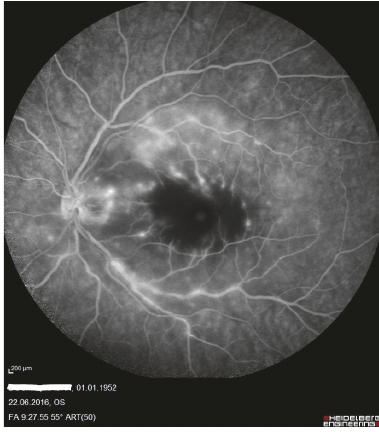
Figure 4: Late phase of fundus fluorescein angiography shows vas- cular hyperfluorescence.